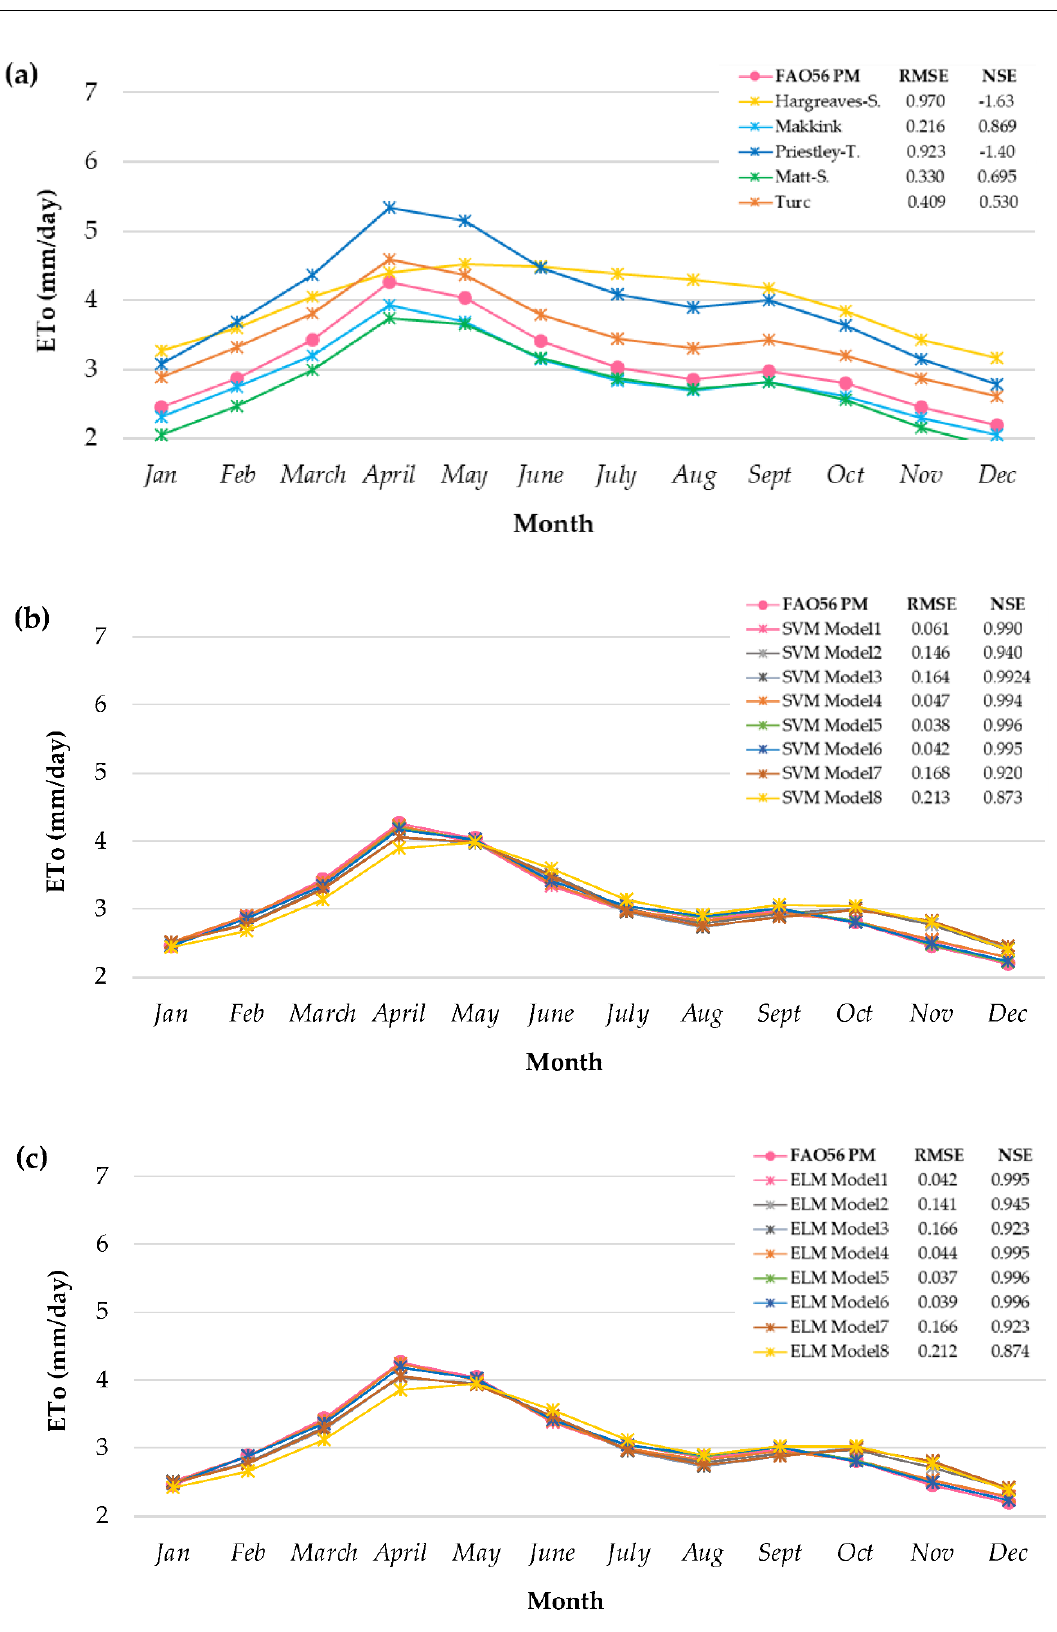
Figure 4. Plots of monthly average daily ETo at the Tanay station, estimated from ( a ) Empirical equations, and calibrated machine learning models of ( b ) Support Vector Machine and ( c ) Extreme Learning